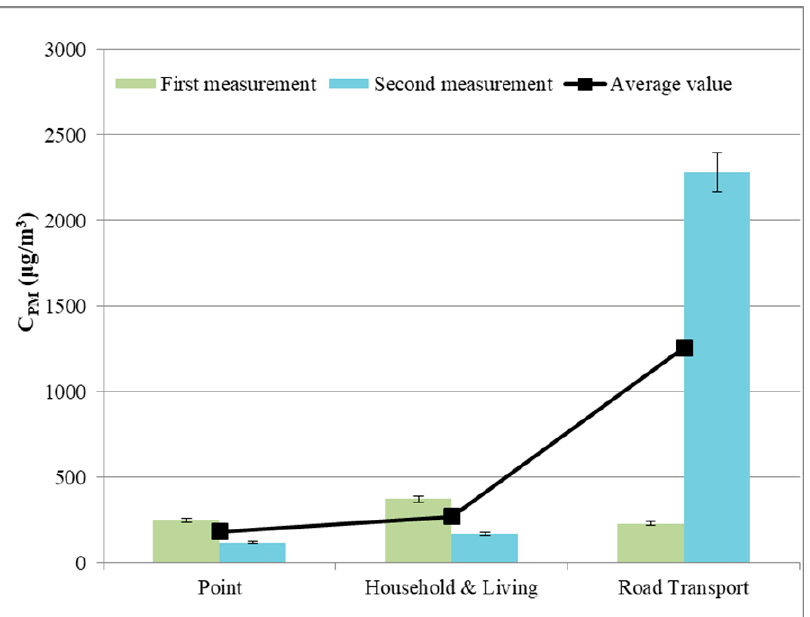
Figure 11. Number of PM10 per cm 3 in Poznan (own study).